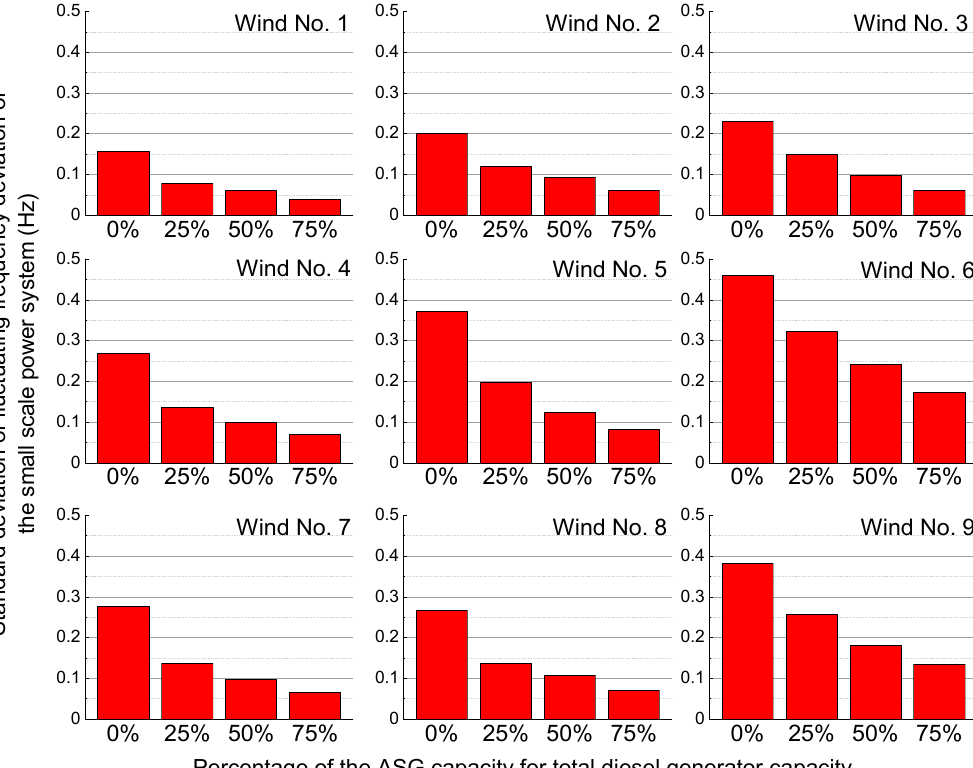
Figure 13. Standard deviation of the power system frequency.